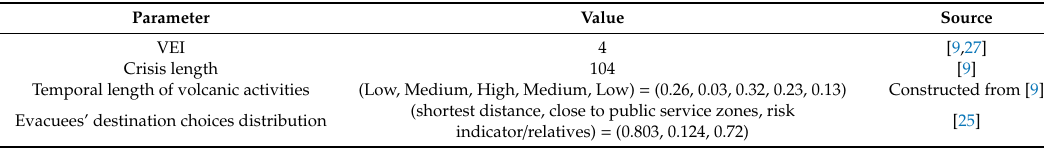
Table 5. Main Parameters of Simulation